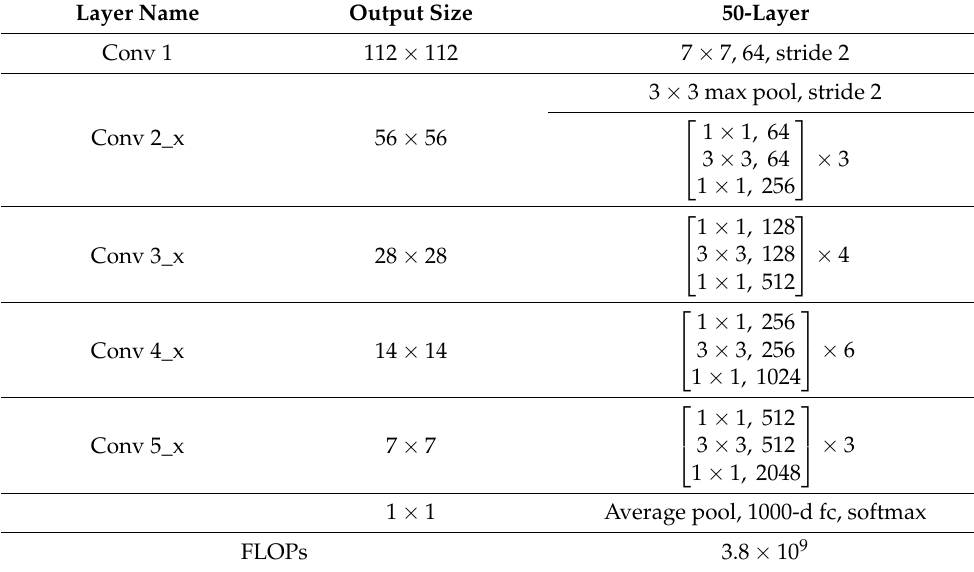
Table 2. Network configuration for